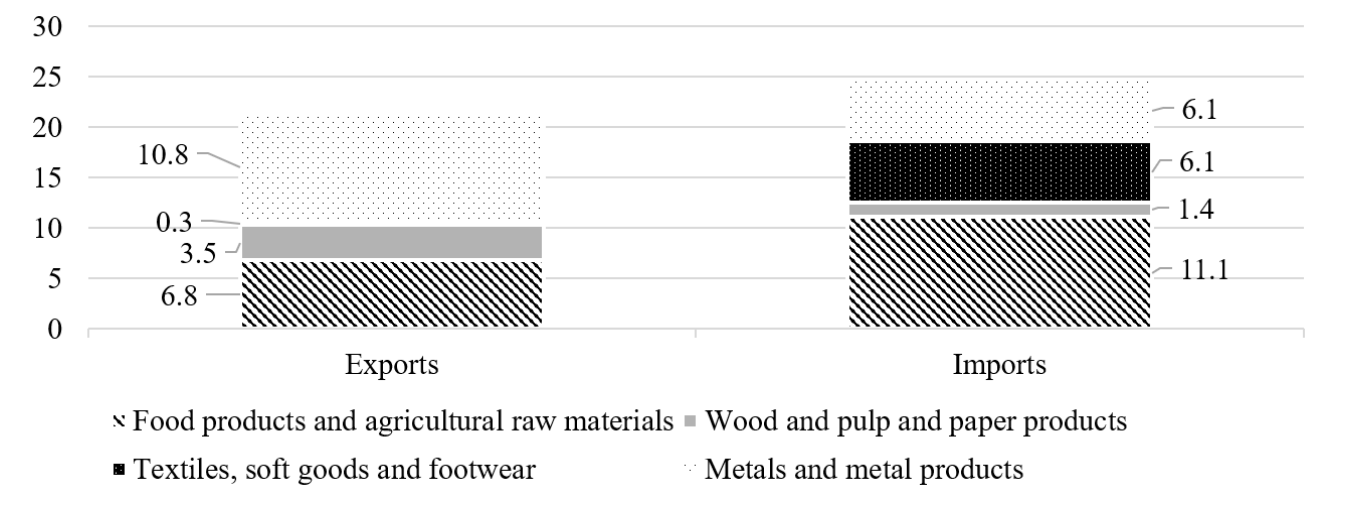
Figure 3. The structure of foreign trade in the EEU in 2021 in terms of goods, %. Source: Compiled by the authors based on data from the Eurasian Economic Commission (2021b). As can be seen from Figure 2, the structure of foreign trade in the EEU in 2021 in terms To estimate the magnitude of COVID-19 in the EEU member states, we considered the change in GDP (economic growth rate) in 2019–2021 (Figure 4).